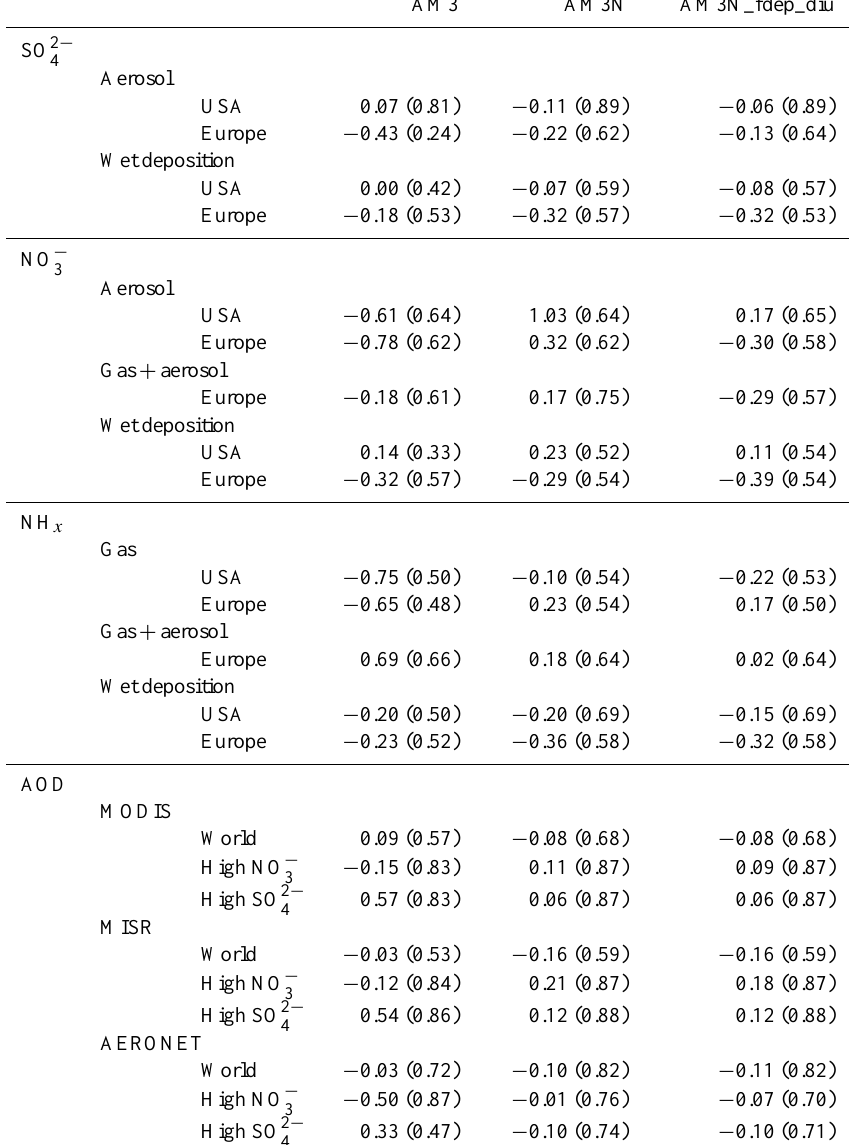
Table 3. Normalized mean bias and correlation coefficient (in parentheses) of monthly model results vs. measurements of surface concentra- tions of SO 2 − , NO − and HNO 3 , NH 3 and NH x , concentrations of SO 2 − 4 3 from AERONET, MISR, and MODIS ∗